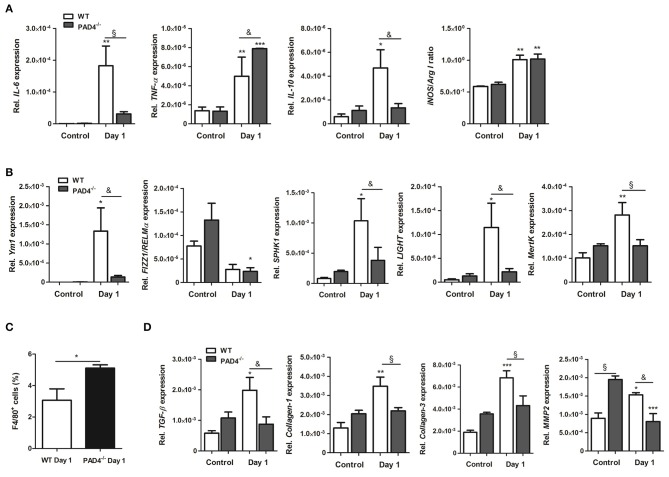
Cardiac expression of inflammation-related genes in PAD4−/− mice at day 1 post-MI. (A) Cardiac gene expression of IL-6, TNF-α, IL-10, iNOS, and Arg I was determined by Real time PCR in mice subjected to permanent LAD ligation (n = 3–4) and control animals (n = 3–5). The ratio of iNOS to Arg I is depicted. (B) To examine polarization toward the M2 phenotype, marker genes specific for the M2a (Ym1, Fizz1/RELMα), M2b (SPHK1, LIGHT), and M2c (MertK) subtypes were analyzed by Real time PCR. n = 3–5. *p < 0.05; **p < 0.01; ***p < 0.001 vs. control. &p < 0.05; §p < 0.01. Two-way ANOVA was performed followed by Newman-Keuls post-hoc test. (C) Percentage of F4/80+ cells was quantified by flow cytometry in dissociated hearts from WT (n = 3) and PAD4−/− (n = 4) mice. *p < 0.05 determined by Student t-test. (D) Cardiac expression of TGF-ß, Collagen-1, -3 and MMP2 was assessed by Real time PCR. n = 3-5. *p < 0.05; **p < 0.01; ***p < 0.001 vs. control. &p < 0.05; §p < 0.01. Two-way ANOVA was performed followed by Newman-Keuls post-hoc test.